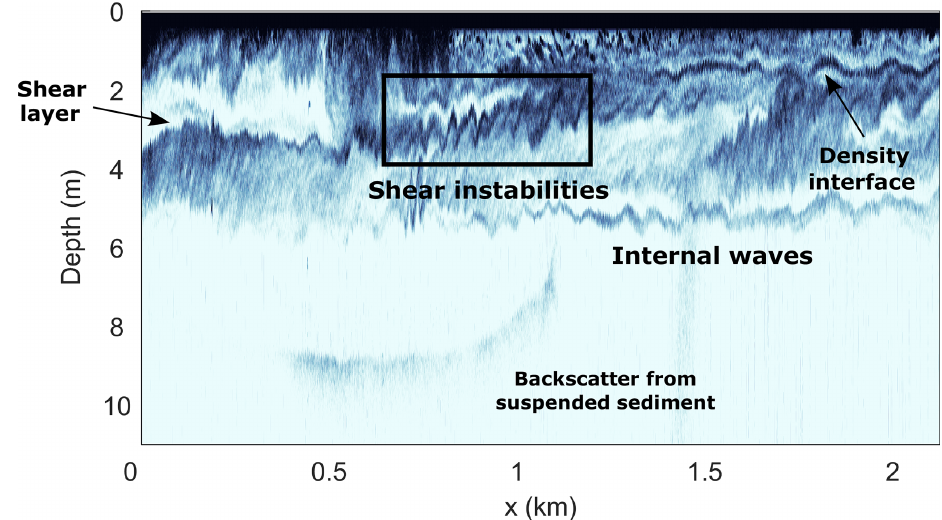
Figure 4. Acoustic backscatter intensity from the vessel-mounted echosounder as a function of distance from the tailrace discharge point. The image is colored so that dark indicates high intensity and white indicates low intensity. The depth of the water column increases from 5m at the end of the tailrace channel ( x = 0) to over 90m in depth over the first 100m from the tailrace discharge point. The location within the fjord corresponding to the distance axis is shown in Fig. 1c.